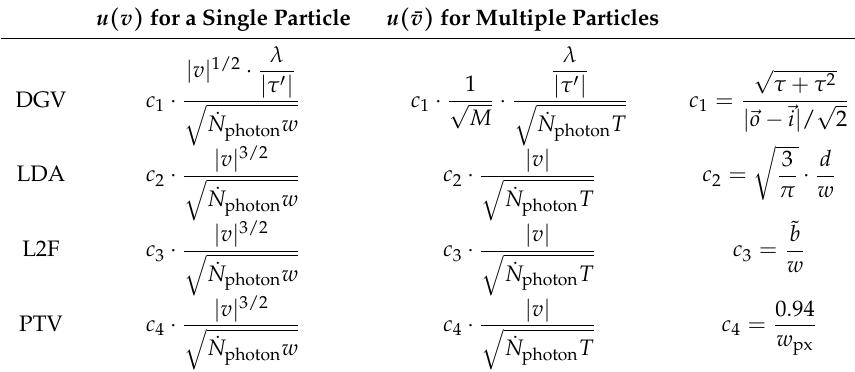
Table 2. Square root of the Cramér–Rao bound due to photon shot noise for Doppler and time-of-flight measurement techniques, which is the minimal achievable measurement uncertainty u ( v ) for a single particle and u ( ¯ v ) for multiple particles, respectively. DGV, Doppler global velocimetry; LDA, laser Doppler anemometer; L2F, laser-2-focus anemometry; PTV, particle tracking velocimetry. u ( v ) for a Single Particle u ( ¯ v ) for Multiple